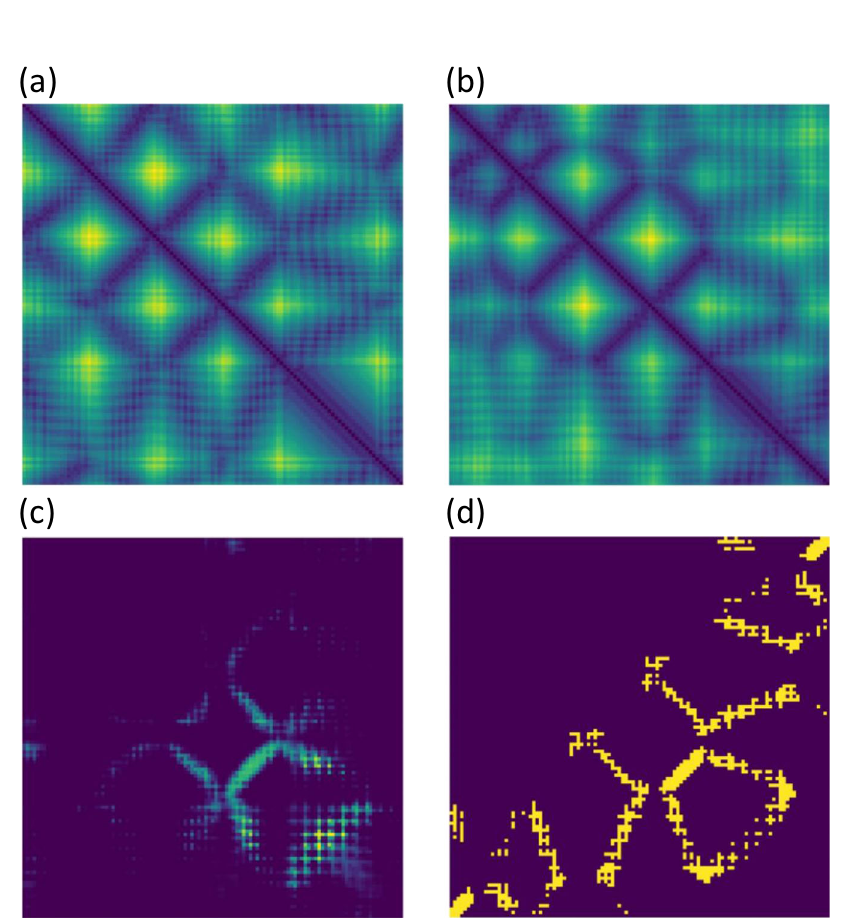
of the top L/5 contact predictions for the target. Each point represents a dimer target in the four test datasets (HomoTest1, HomoTest2, HeteroTest1 and HeteroTest2).